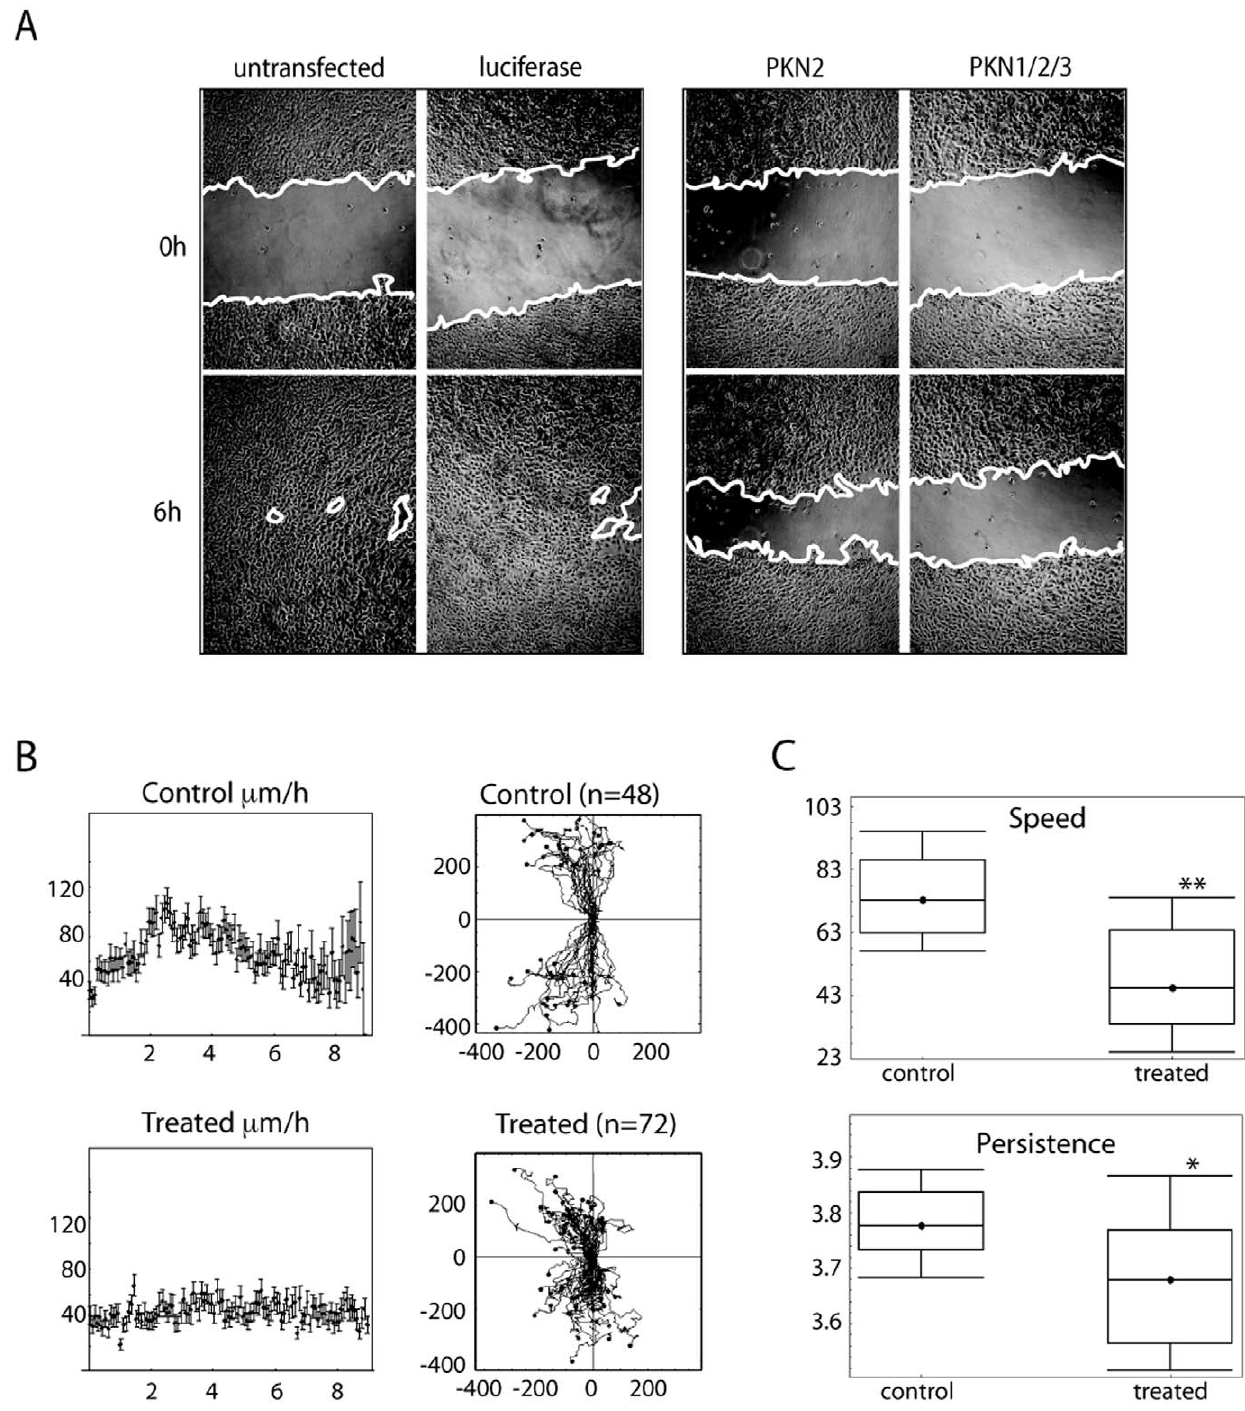
Figure 2. Loss of PKN reduces speed and directionality of 5637 bladder cells during wound healing. 5637 cells grown on collagen coated plates were transfected with siRNA against luciferase, PKN1, PKN2 or PKN3 as indicated. At 3 days post transfection confluent cell monolayers were scratched and wound closure filmed with a lowlight microscope. A. Images were taken at the time of wounding (t 0 h) and after 6 h of migration as indicated. B. Individual cells were picked at random and tracked during migration using AQM-Tracker software. Graphs show the speed of movement in control and PKN knock down cells over 6 h. The boxed traces represent the length and direction of cell movement of each individually tracked cell plotted from the same point of origin C. Box and Whisker graphs show the range of speed and persistence of all tracked control versus PKN knock down cells. The comparison was done using Mathematica software. Stars represent t , 0.01 (**) or t , 0.5 (*).